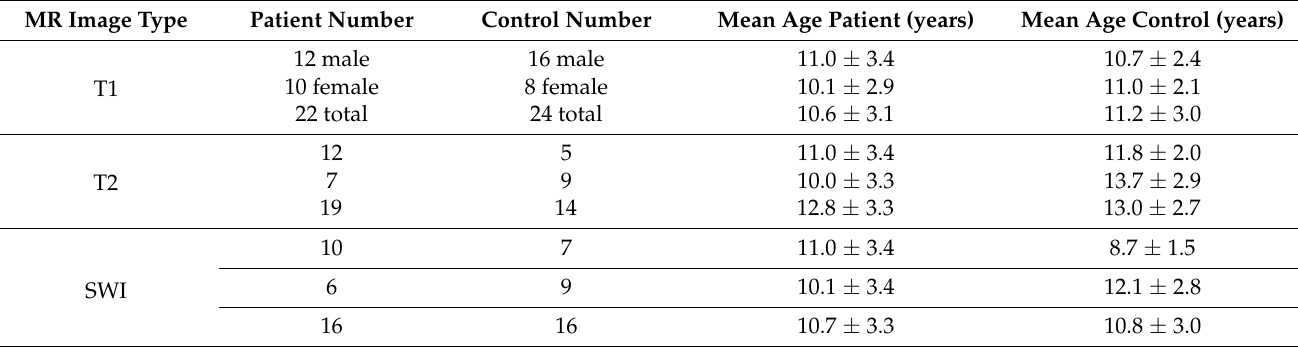
Table 1. Patient and control numbers, sex, and mean ages with standard